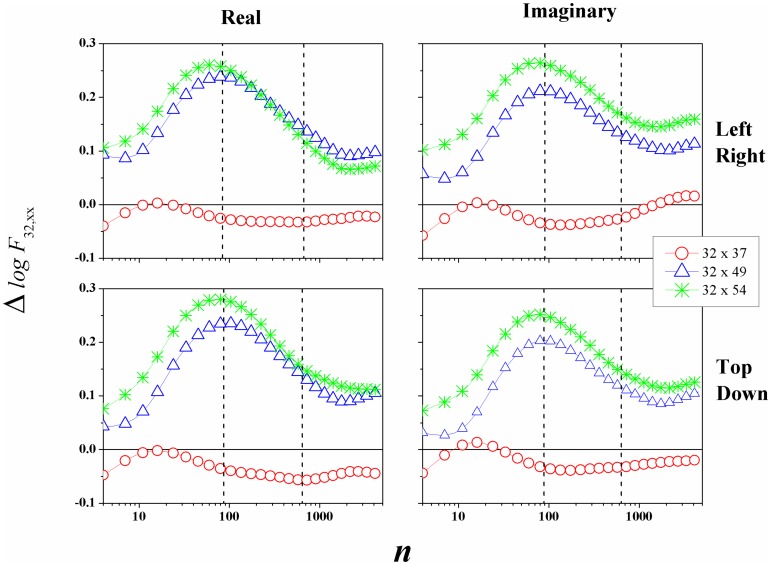
(Color on-line) Mean value of ΔlogF32;xx between the channel F332 and others three.Every curve represent the difference between F332 and: (○) F637, (△) P349, and (*) P654.